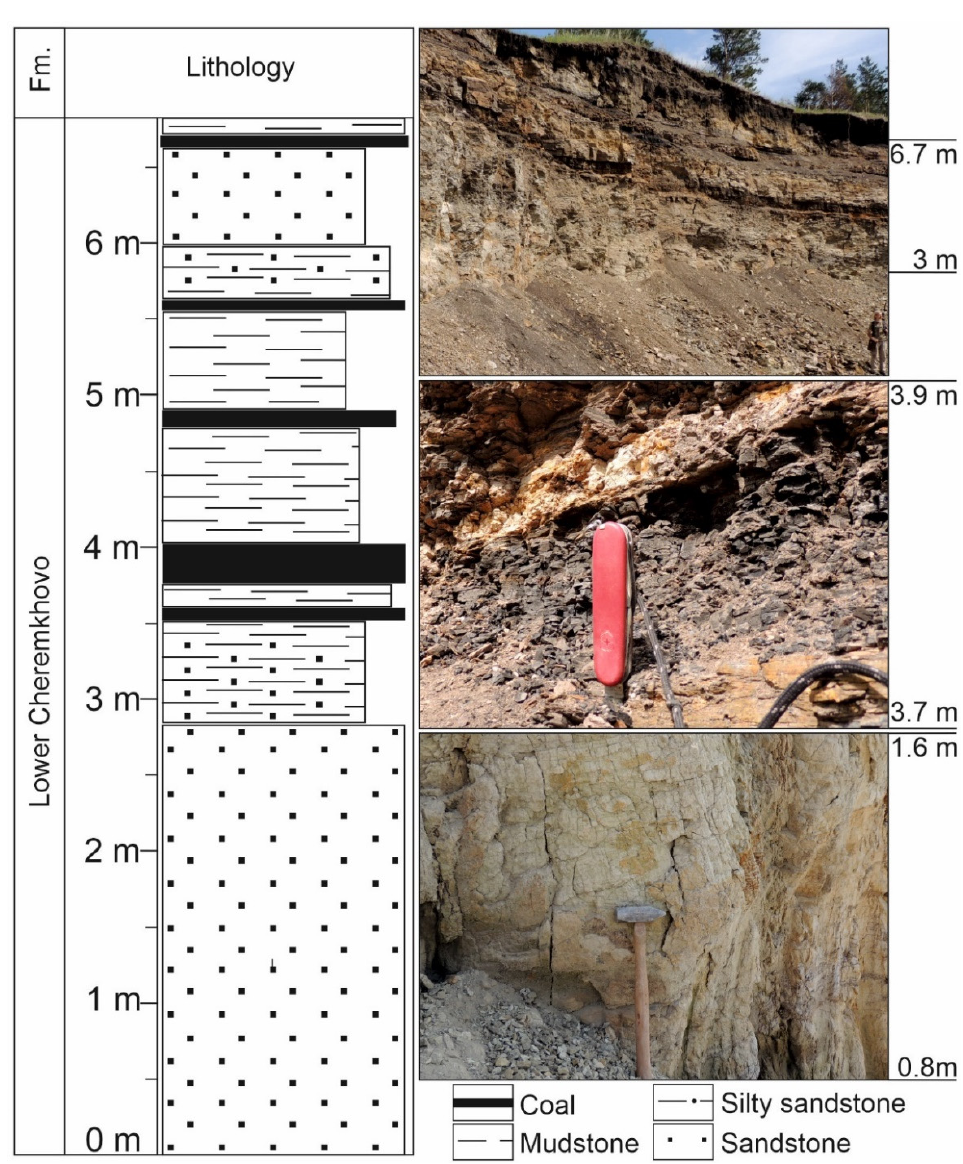
Figure 4. Section of the lower Cheremkhovo Fm. sampling in the area of Kutulik village.